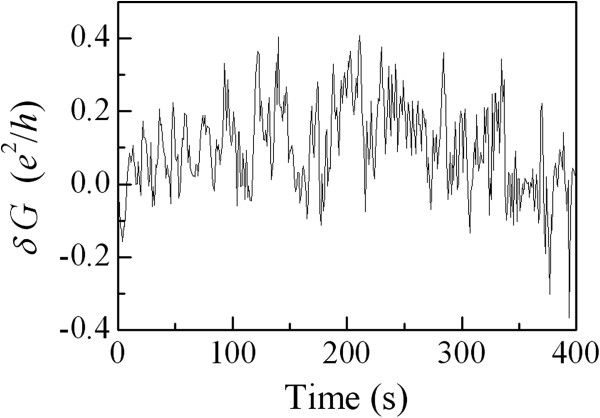
TUCFs for the NW1 device. Conductance variation δG = G − 〈G〉 versus time for the NW1 device at T = 1.73 K plotted in units of the quantum conductance e2 / h.